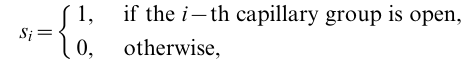
of the two capillary groups, where